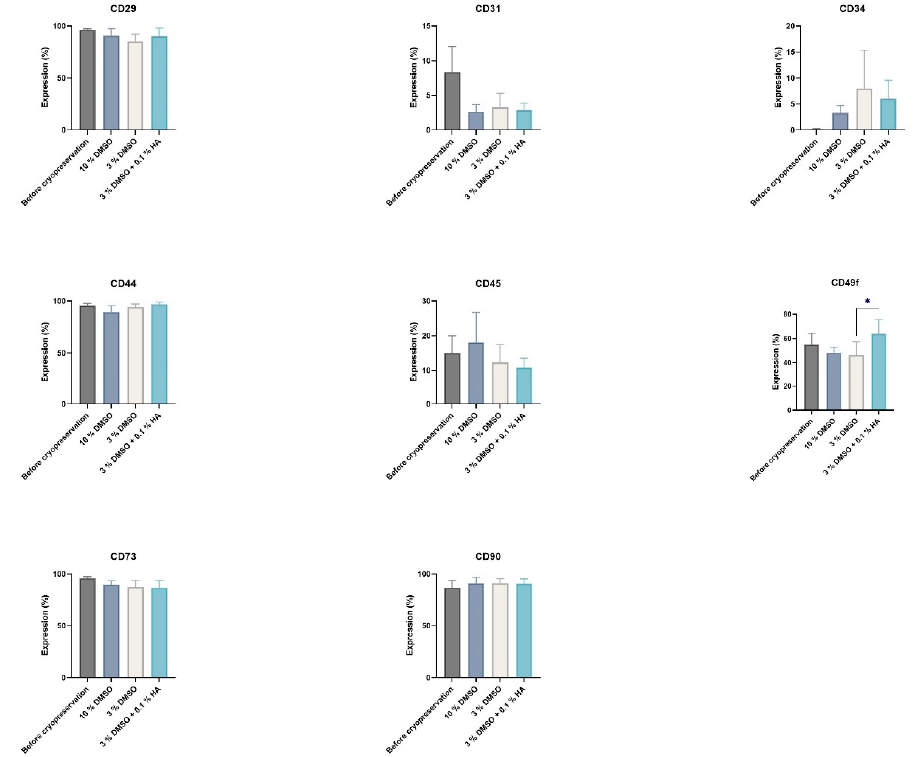
Figure 4. Phenotype profiles of DPSCs evaluated prior to and 2 weeks post-cryopreservation. The layouts of graphs illustrate percentages of positive cells, determined as the percentage with a fluorescence intensity greater than 99.5% of the negative isotype immunoglobulin control. Data are presented as a mean and SD plotted as error bars. The statistical significances (* p < 0.05) were calculated using either one-way ANOVA, followed by Dunnett’s multiple comparison test for continuous variables, or Friedman’s test, followed by Dunn’s multiple comparison test on ranks for nonparametric variables. The Shapiro–Wilk test or Kolmogorov–Smirnov test were used for normal distribution evaluations.